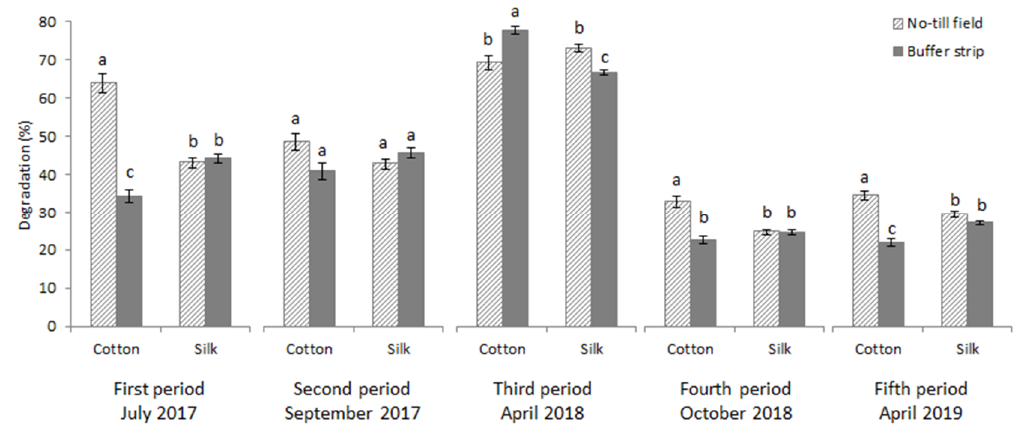
Figure 5. Degradation percentage of mean values of both treated and non-treated cotton and silk threads of Fertimetro buried in different periods in the soil of the NT field and the vegetated BS. Pairs of data sharing the same letter are not significantly different ( p > 0,05). Bars report the standard error.